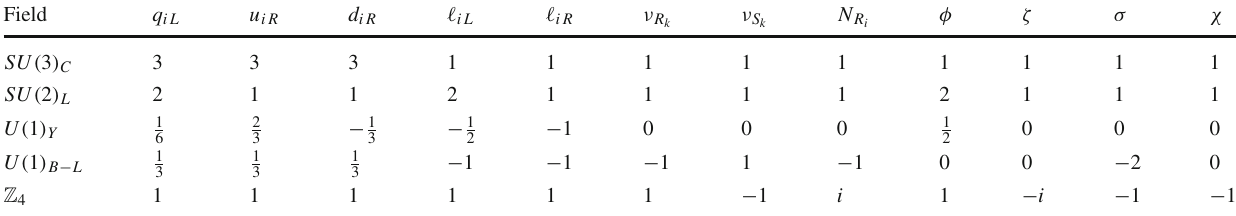
by three columns for the new sterile fermions, while de SM fermions are collected on the four first ones. More details are provided in the main text. The indices run as follows: i = 1 , 2 , 3 and k = 1 ,